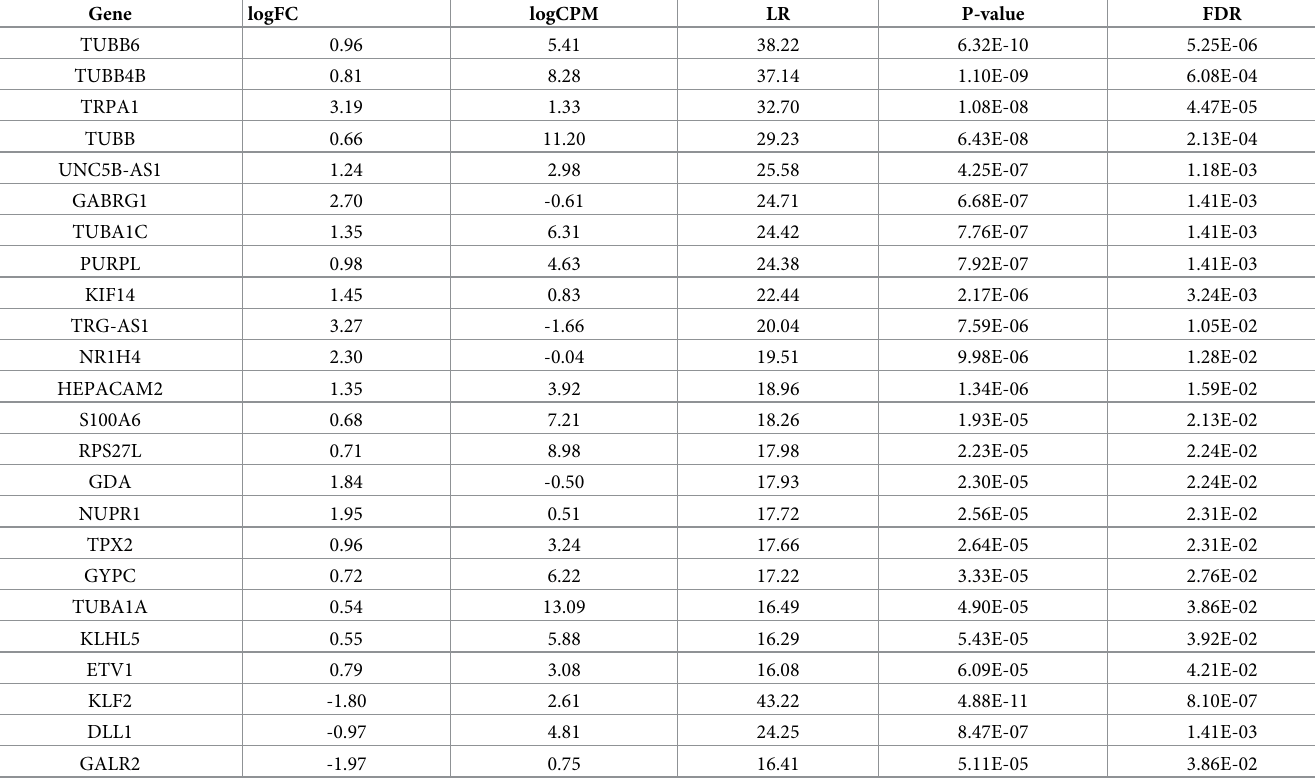
Table 1. Differential gene expression following paclitaxel treatment of iPSC-dSN. Comparison between paclitaxel and vehicle treatment of iPSC-dSN in clusters 2, 7, and 8 (FDR < 0.05).